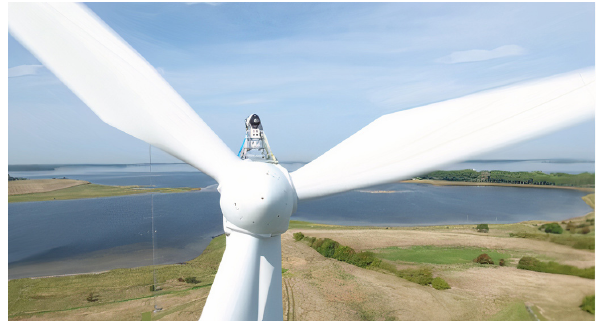
Figure 3. Three lidars sitting on the nacelle of the V52 wind turbine at DTU Risø campus: SpinnerLidar (top), WindVision (middle) and WindEye